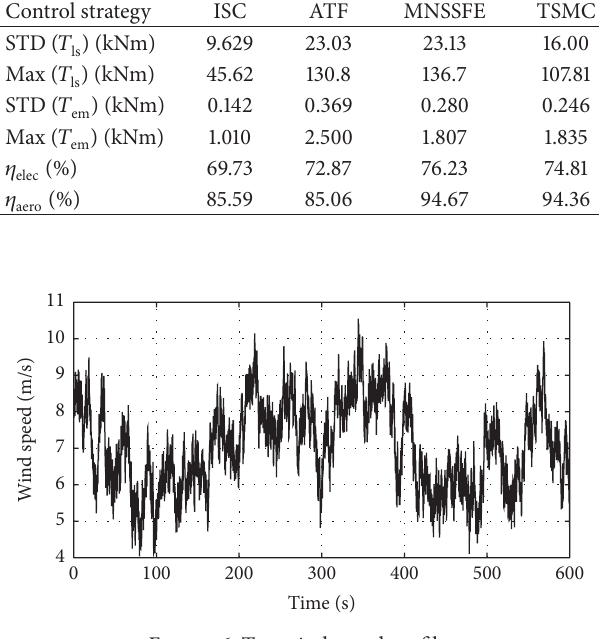
Figure 6: Test wind speed profile.